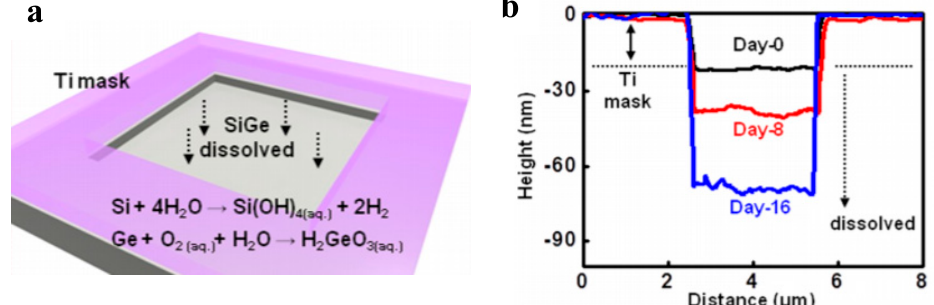
Figure 20. ( a ) Scheme of the experimental setup used to measure the Si, Ge and SiGe dissolution rate, in the form of a patterned square opening (3 μ m × 3 μ m × 30 nm) within a Ti layer deposited on single-crystalline I, SiGe and Ge (100) wafers. ( b ) Height profiles during hydrolysis of SiGe in a bu ff er solution at pH 10 and 37 ◦ C, after day 0, day 8 and day 16. Adapted from from [91]. Copyright 2015 American Chemical